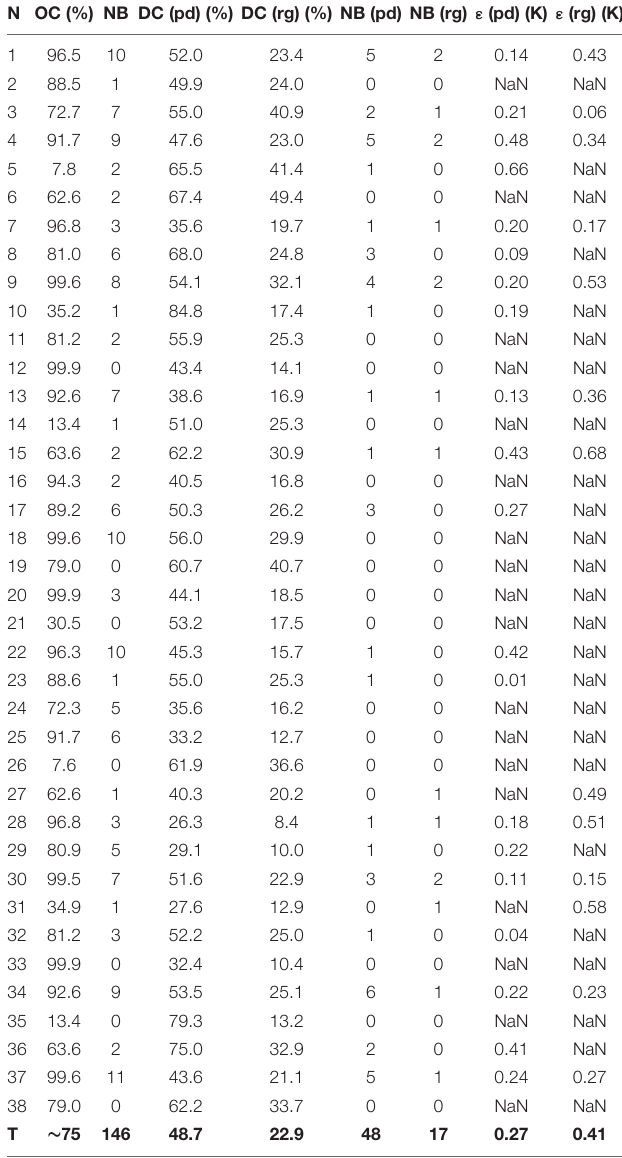
TABLE 5 | Statistical information of retrieved results for 38 granules from MC using two different methods of PDSST and RGSST5 for the month of August